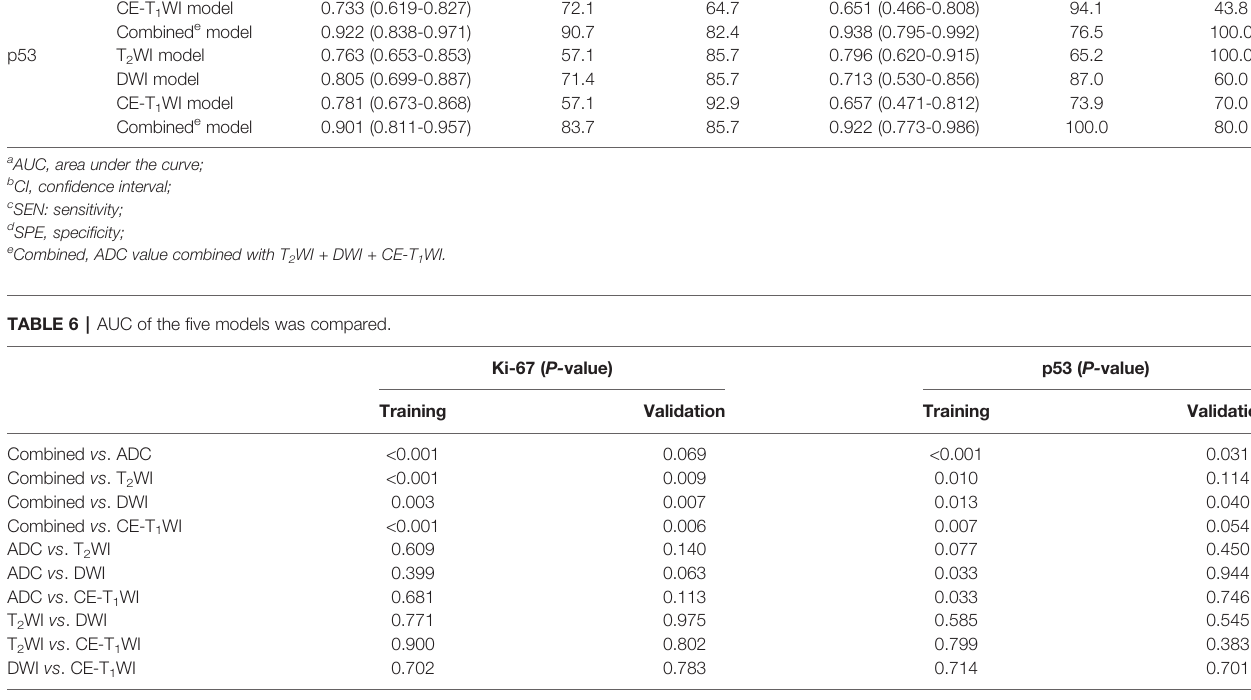
water molecules, but also affected by the microcirculation of the blood and tumor heterogeneity; therefore, they cannot truly re fl ect the movement of water molecules in tissues.